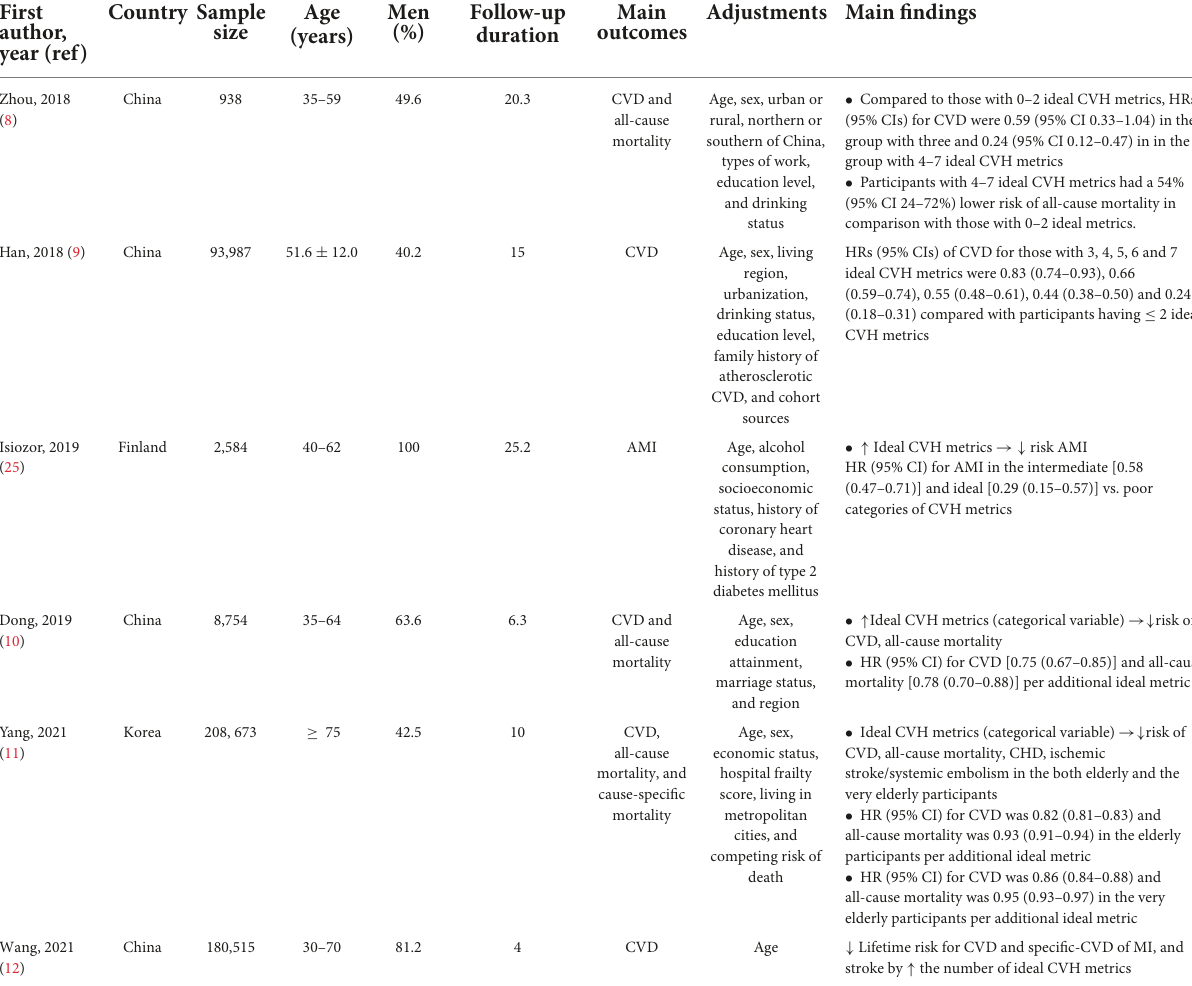
TABLE 6 Prospective investigations on associations between cardiovascular health metrics and risk of cardiovascular diseases and